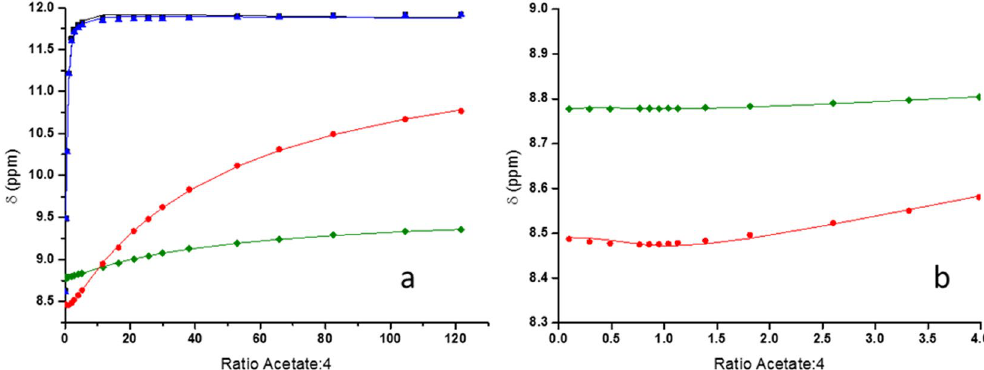
Figure 4. ( a ) 1 HNMR (600 MHz) binding curves for urea (black square and blue circle), C5 naphthalimide (green diamond) and 4-amino NH proton resonances (red circle), with the fits calculated using a 2:1, 1:1 and 2:1 binding model in HypNMR for complexes formed between 4 and tetrabutylammonnium acetate represented by the coloured lines. ( b ) An expansion of Fig. 4a showing the change in chemical shift of the C5 naphthalimide and 4-amino NH protons.